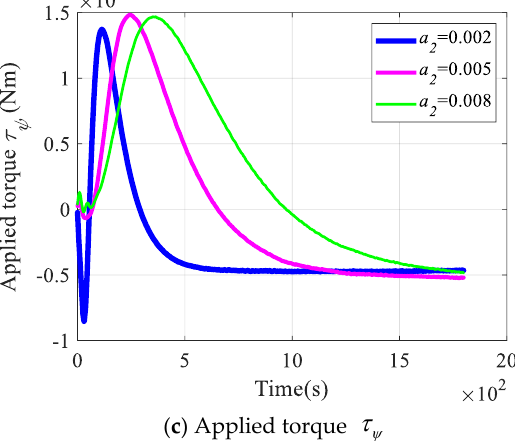
Figure 13. Control commands of controlled AUSV with respect to different control gains a 2 .